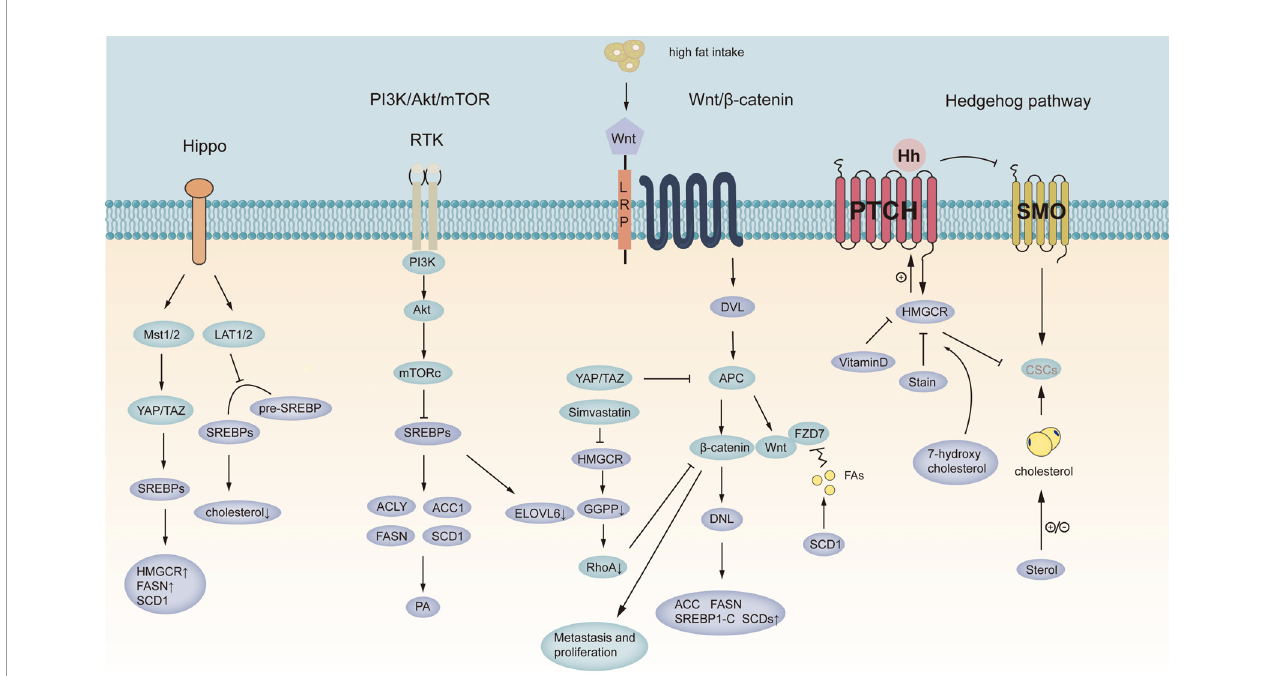
FIGURE 2 | Targeting signaling pathways in gastric cancer. Schematic representation of the Wnt, hedgehog, PI-3K, and Hippo pathways in GC. The purple circles represent lipid metabolism-related pathways in gastric cancer, and the blue circles represent signaling pathways in gastric cancer. YAT/PAZ, Yes-associated protein/ transcriptional coactivator with PDZ-binding motif; LAT1/2 represents Large tumor suppressor 2; MST1/2, Macrophage stimulating 1/2; SREBPs, sterol regulatory element-binding protein; Pre-SREBPs, Pre-sterol regulatory element-binding protein; HMGCR, 3-hydroxy-3-methyl-glutaryl-CoA reductase; FASN, fatty acid synthase; SCD1, stearoyl-CoA desaturase 1; ACLY, ATP-citrate lyase; ACC1, acetyl-CoA carboxylase; ELOVL6, fatty acid elongate 6; PA, phosphatidic acid; PI-3K/AKT/MTORC1, phosphoinositide 3-kinase (PI3K)-protein kinase B (AKT)-mechanistic target of rapamycin (mTOR) signaling; DVL, Doppler Velocity Log; APC, Adenomatous polyposis coli; GGPP, geranylgeranyl pyrophosphate; CSCs, cancer stem cell; FZD7, Wnt receptor